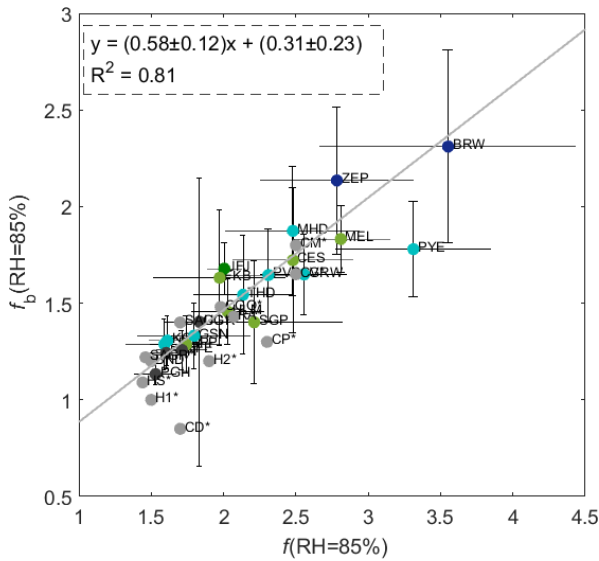
Figure 2. Scatterplot of f b (RH = 85%) versus f (RH = 85%) at λ = 550nm. Dots represent the mean value and error bars 1 stan- dard deviation. The figure includes the results of a weighted bivari- ate fit according to York et al. (2004). The colors indicate the site type (dark green for mountain site, light green for rural, cyan for ma- rine, dark blue for Arctic and black for urban sites); other studies are plotted in gray. Those studies are as follows. SAG refers to Sagres (Portugal), with SAGP and SAGC referring to polluted and clean conditions, respectively (Carrico et al., 2000); CGO refers to Cape Grim (Australia) (Carrico et al., 1998); BND refers to Bondville (Illinois, USA) (Koloutsou-Vakakis et al., 2001); H1 and H2 are av- erage values from two flights made off the west coast of the US (Hegg et al., 1996); CM, CP, CV and CD refer to marine, polluted, volcanic and dust-dominated conditions during the ACE-Asia cam- paign in the North Pacific Ocean (Carrico et al., 2003); and RA and HS refer to regional southern African air and heavy smoke, respec- tively (Magi and Hobbs,